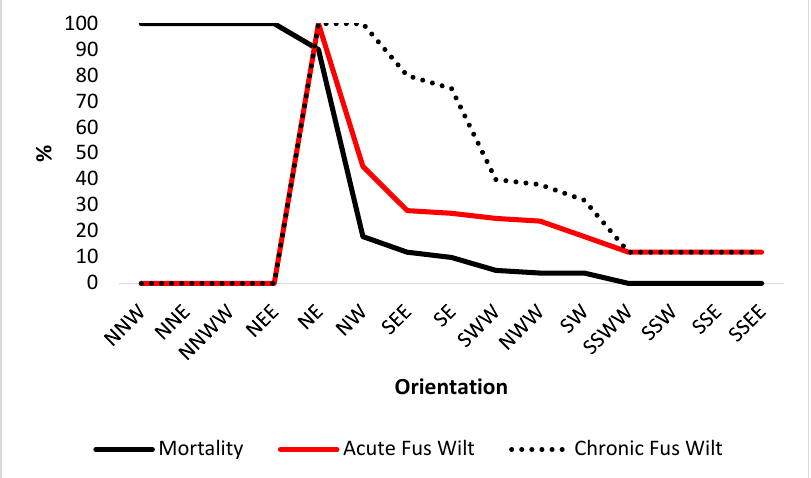
Figure 6. Change in OP mortality, acute Fusarium wilt and chronic Fusarium wilt due to the change in combined suitable climate for growing OP in the 15 regions considered.